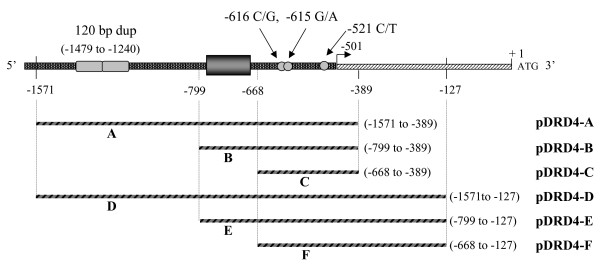
Schematic representation depicting the location of the six 5' deletion mutant variants in the DRD4 gene promoter (pDRD4-A, B, C, D, E and F). The putative repressor region is indicated by a shaded box. The localization of several important SNPs and the 120 bp duplication region are also shown. The arrow at -501 denotes the transcription start site.